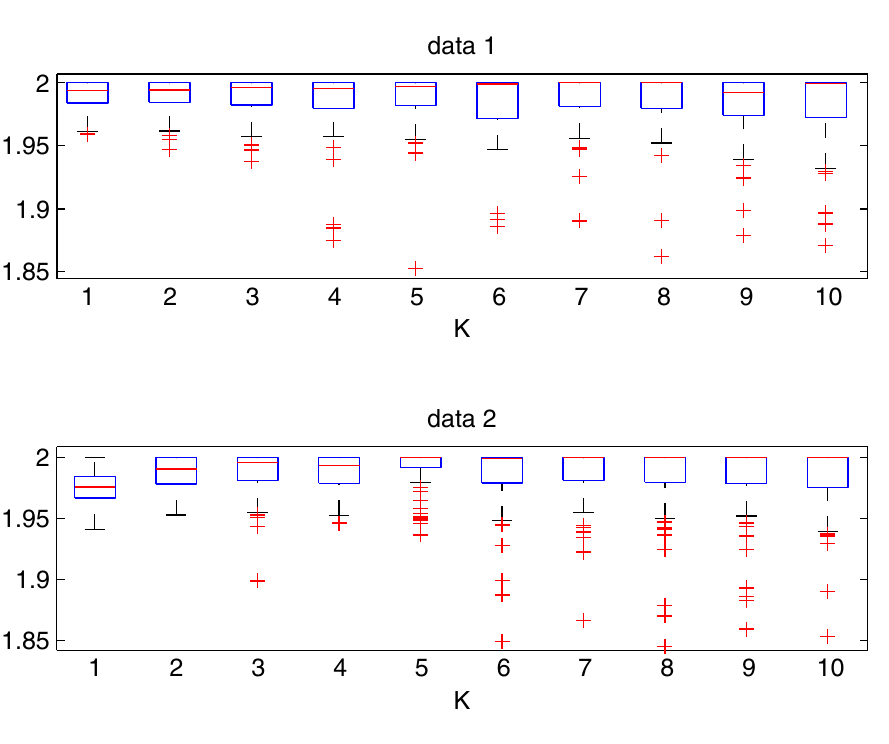
Fig 14. Estimated α values for the data1 from the top left panel of Fig 13 (top panel) and for the data2 from the top right panel of Fig 13 (bottom panel). The box plots were constructed from 100 bootstrap samples of length